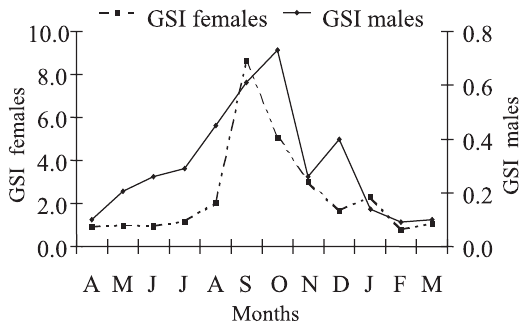
Fig. 1. Monthly variation of the mean values of the gonadosomatic index (GSI) on females and males of Bryconamericus iheringii from rio Vacacaí, RS, Brazil, from April 2001 through March 2002.